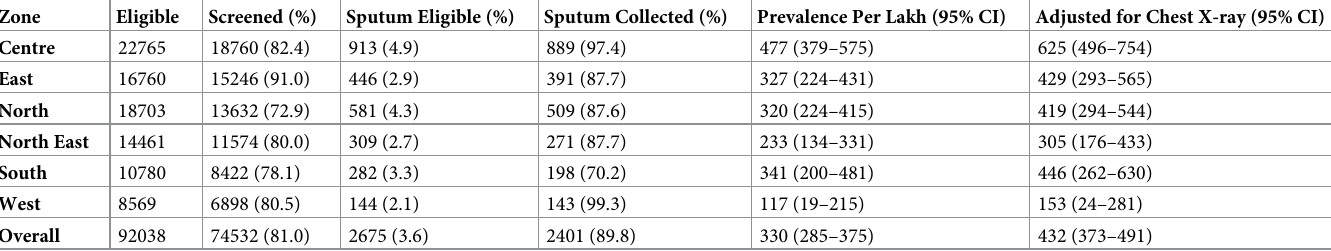
Table 1. Prevalence of smear and/or culture positive pulmonary tuberculosis by zone (per 100,000 populations).